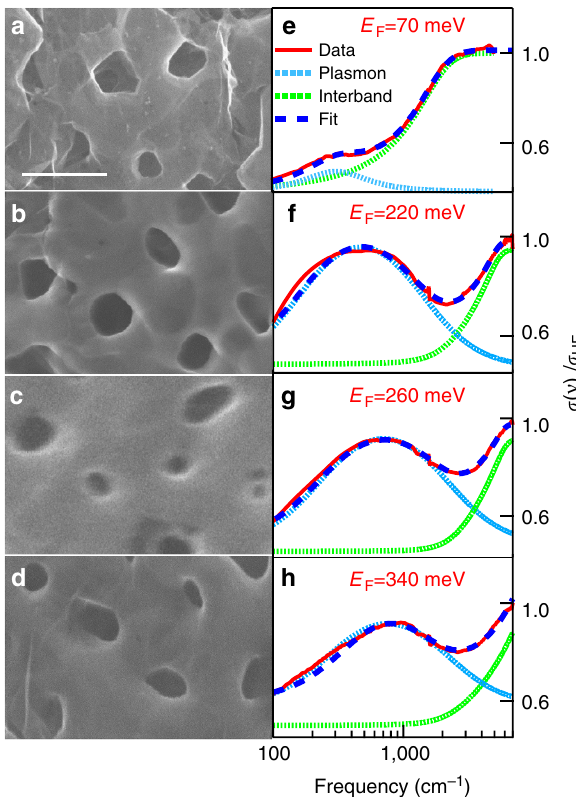
Figure 2 | Optical properties of nanoporous graphene at fixed pore size for different Fermi energies. ( a – d ) SEM images of nanoporous graphene samples with the same average pore size p ¼ 200 ± 50nm, and an increasing Fermi energy (from a – d ). The scale bar corresponds to 500nm. ( e – h ) Optical conductivity curves with relative value of Fermi energy. The whole fitting, the plasmon and the interband components (see text) are represented by blue-dashed, blue-dotted and green-dotted lines, respectively. SEM, scanning electron microscope.